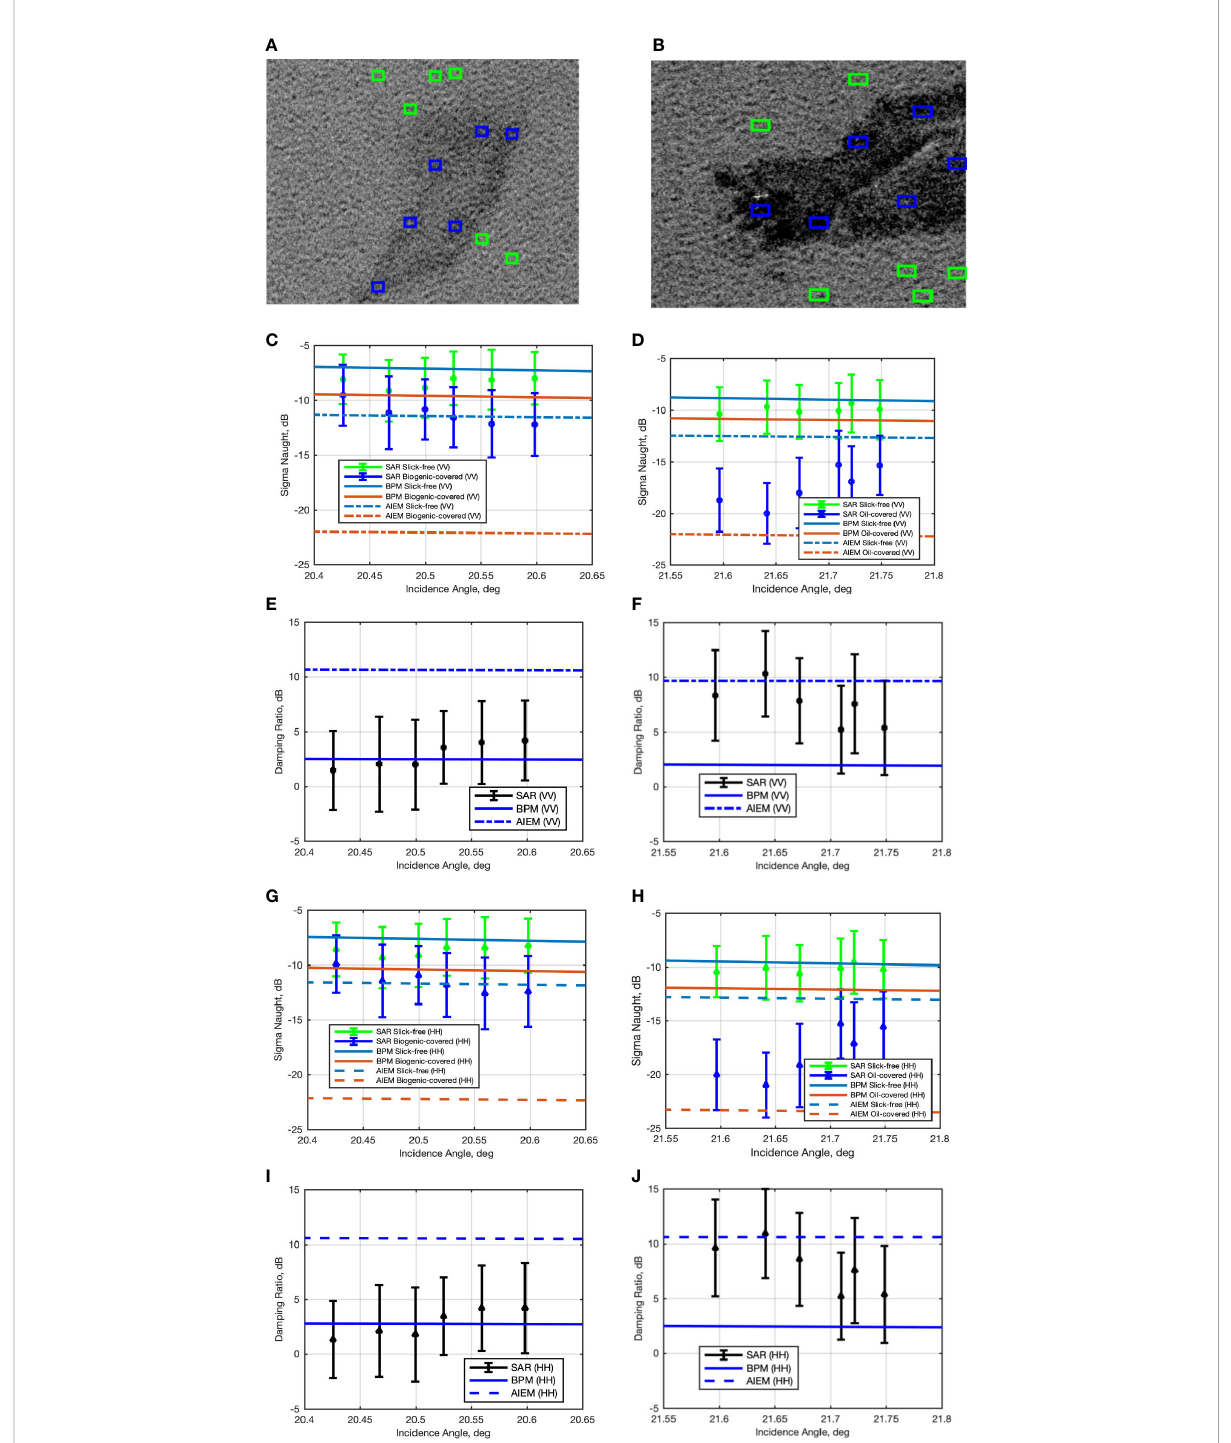
FIGURE 5 Experiments related to the TSX SAR scene acquired on June 8, 2011, at low incidence angle (about 21°), see Table 1. The fi rst row are excerpts of the TSX SAR scene that includes (A) plant oil and (B) crude oil. The slick-free and slick-covered ROIs selected for quantitative analysis are also annotated in green and blue colors, respectively. The second row are the contrast of VV-polarized NRCS measured within slick-free and slick- covered ROIs with predictied ones in the case of (C) plant oil and (D) crude oil. The third row are the contrast of VV-polarzied DR measured from ROIs with predicted ones in the case of (E) plant oil and (F) crude oil. The forth row (G, H) are the same as (C, D) but for HH-polarized NRCS. And the fi fth row (I, J) are the same as (E, F) but for HH-polarized